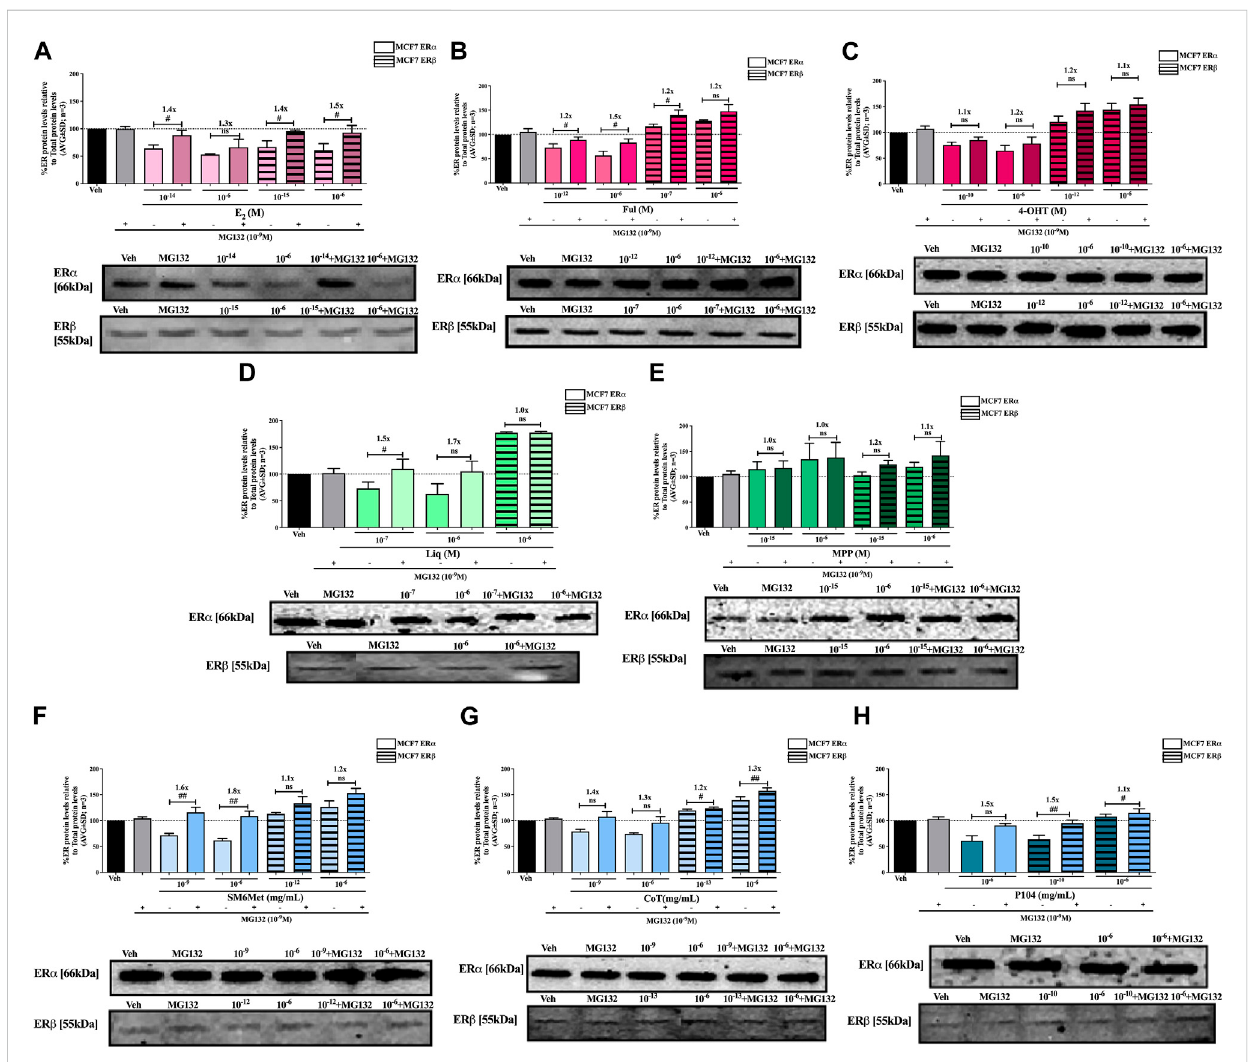
FIGURE 6 Effect of MG132, a UPS inhibitor, on the modulation of ER α and ER β protein levels in MCF7 cells. MCF7 cells were steroid starved for 24 h and then treated with either vehicle (DMSO) or LogIC 50 (from Figure 2; Table 2 with µg/ml converted to M) and saturating (1 μ M) concentrations of (A) E 2 or the SOCs, (B) fulvestrant (Ful) or (C) 4-OH-tamoxifen (4-OHT), or the ER subtype selective ligands, (D) liquiritigenin (Liq) or (E) methyl-piperidino-pyrazole (MPP),orLogIC Westernblot.Thewesternblotsshownasinsertarerepresentativesofthreeindependentexperiments.Forquanti fi cation,theintensityoftheER α andER β bands were determined with MyImage Analysis software, after which the obtained values were normalized to total protein content and expressed as a percentage(AVG±SD)ofDMSO,whichwassetat100%.Fold-changeisindicatedabovethebars.Statisticalanalysiswasdoneusingatwo-tailed t -testto establish signi fi cant differences due to addition of MG132 ( # p < 0.05, ## p < 0.01 and ### p <